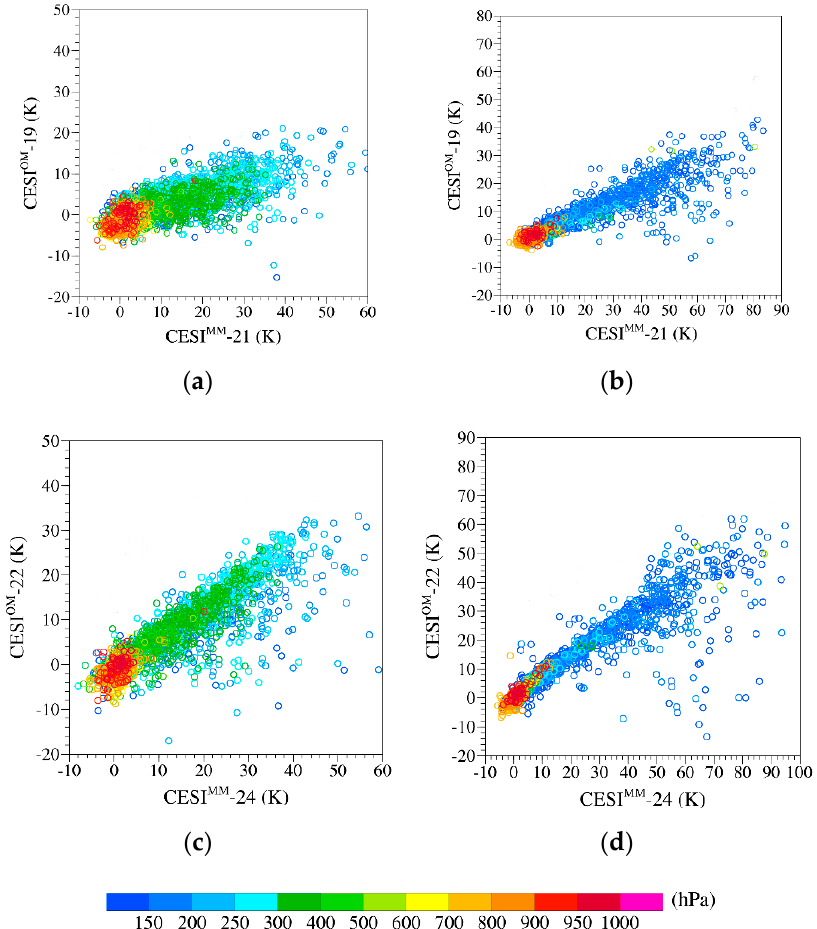
Figure 15. Scatter plots of ( a , b ) CESI MM -21 versus CESI OM -19 (~628 hPa) and ( c , d ) CESI MM -24 versus CESI OM -22 (~718 hPa) from the AIRS / HIRAS overlapping area at ascending nodes over domain 1 (left panels) and domain 2 (right panels) on 2 February 2019. The colors indicate AIRS ice cloud top pressure (Figure 12b).